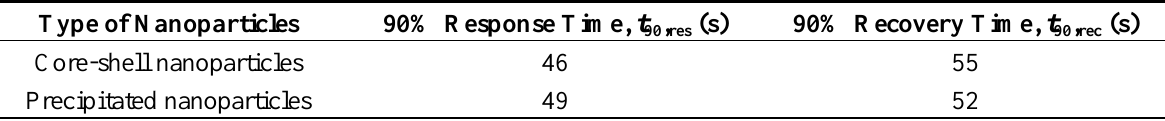
Table 1. Response and recovery times of the